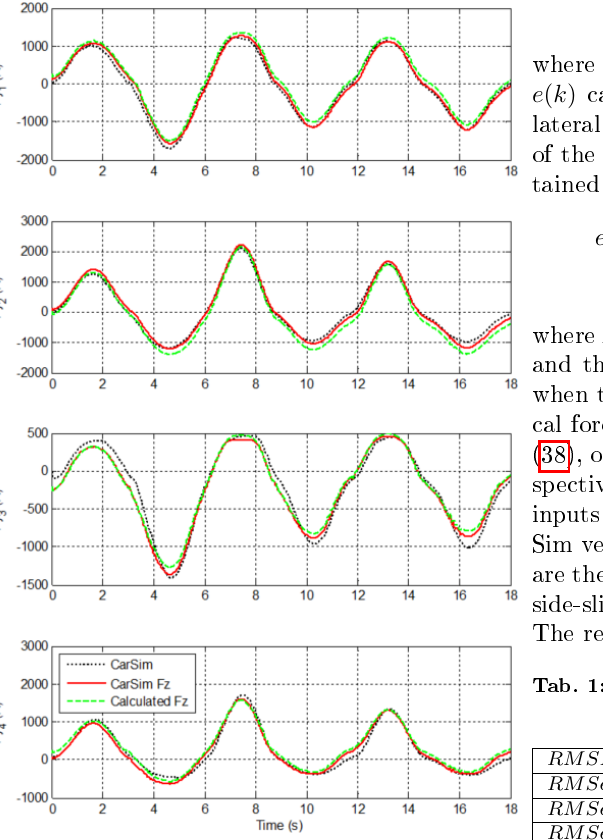
Fig. 6: Estimation of the four-wheel-lateral-tire forces.